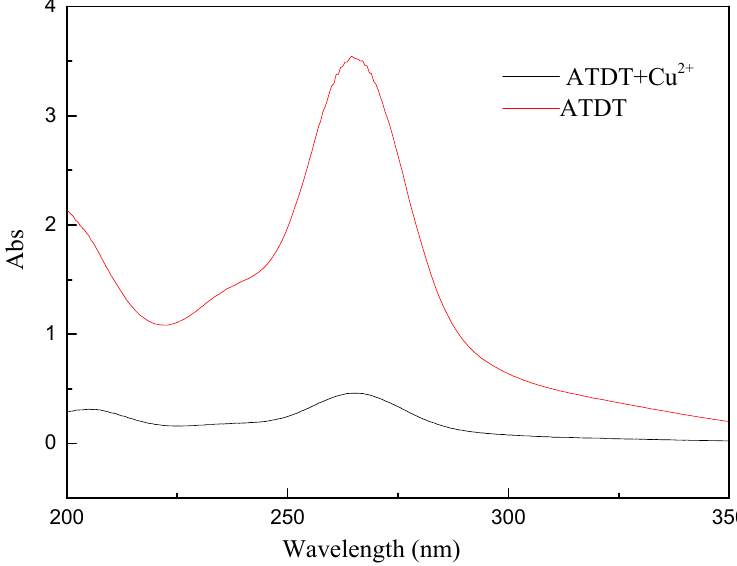
Figure 5. UV spectra of ATDT in the presence and absence of Cu 2+ ions.